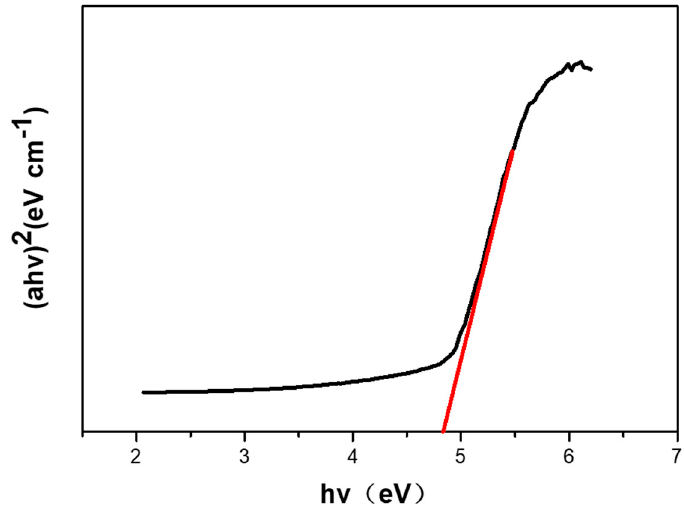
Figure 5. Ultraviolet-visible absorption spectrum of the β -Ga 2 O 3 NWs.